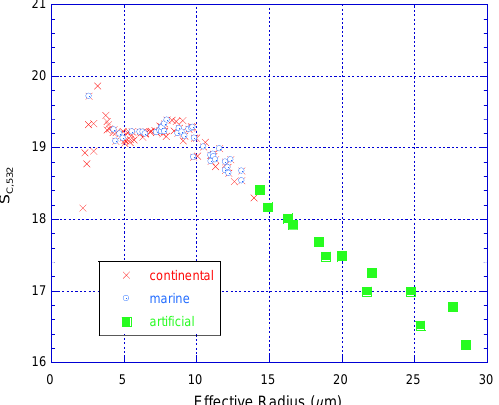
Figure 2. Water cloud lidar ratios calculated as function of effective droplet radius; red crosses and blue diamonds use in situ measure- ments of droplet radius (Miles et al., 2000), whereas green squares are derived from modeled distributions for clouds having larger droplet